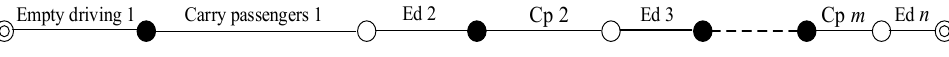
Figure 1. Sequence of a taxi’s one-day trajectory state segments. There are m passenger travel seg- ments.